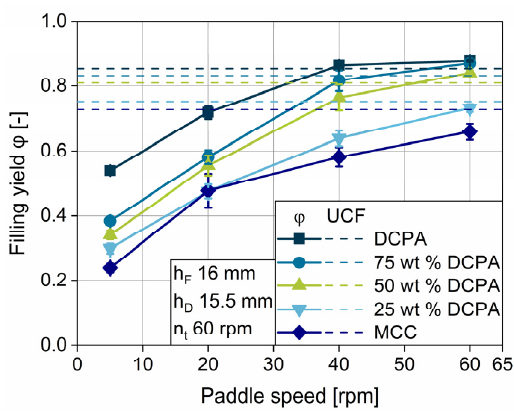
Figure 16. Impact of the paddle speed on the filling yield for the five formulations used at a turret speed of 60 rpm, a fill depth of 16 mm and a dosing depth of 15.5 mm.